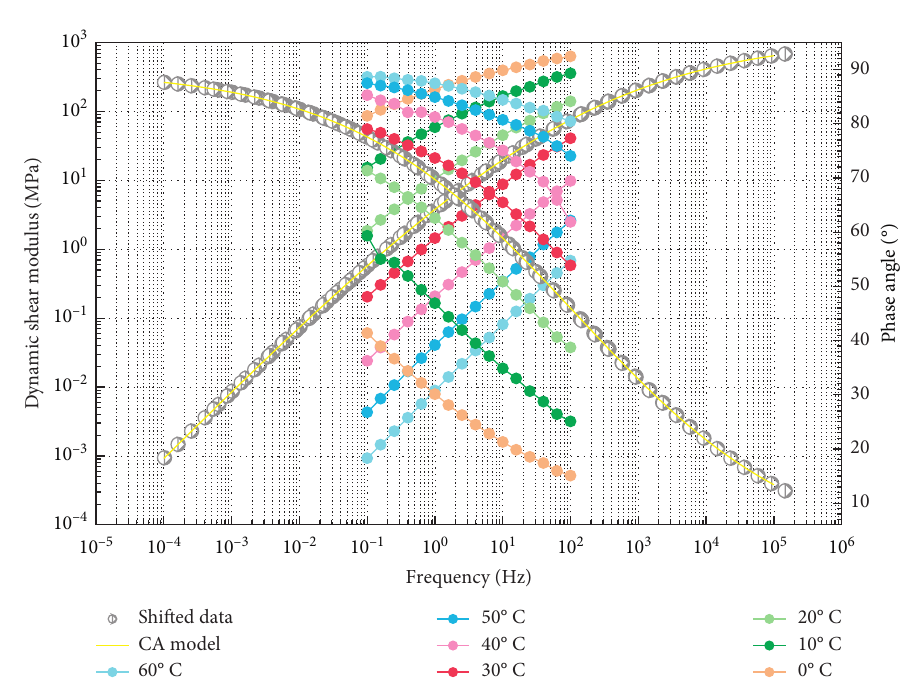
Figure 4: Master curve construction of mastic